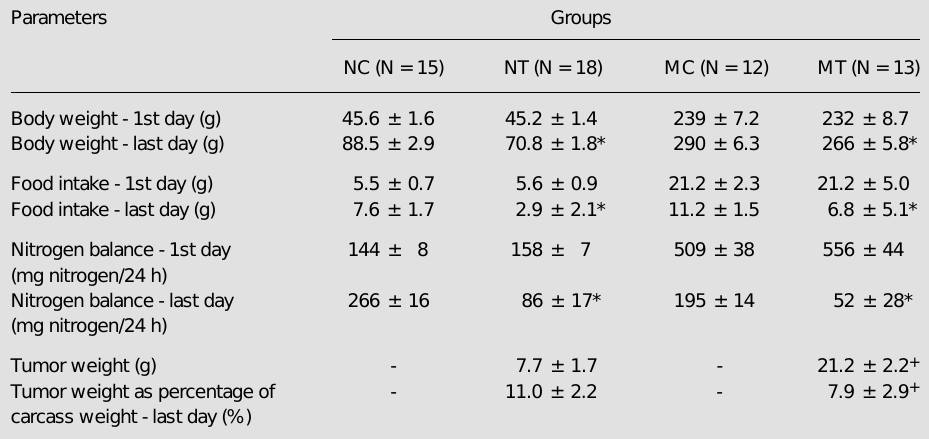
Figure 1 - Effect of Walker 256 carcinoma growth on intestinal absorption of glucose (A), me- thionine (B) and leucine (C) in newly weaned and mature